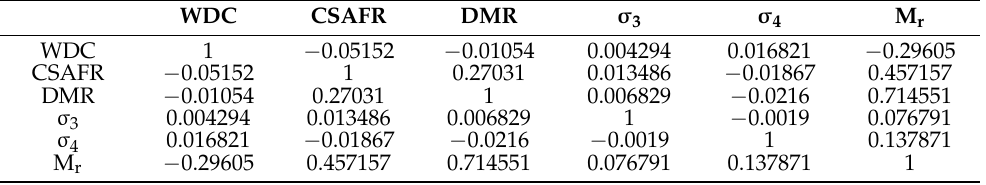
Table 2. Linear Pearson’s correlation indices for the inputs and the target variable considered in this